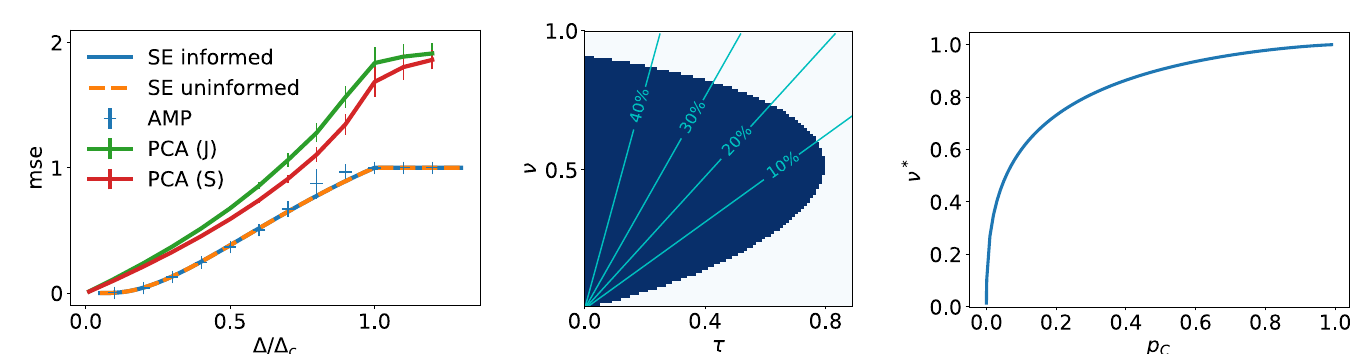
Fig 1. ( Left ) Reconstruction and performance of the message-passing algorithm for binary patterns. We plot the mse (7) obtained by the AMP algorithm (32) as a function of the effective noise Δ (9) (blue crosses). We plot the performance of the algorithm starting from random (15) and informed (16) initialisations. Solid lines depict the prediction obtained from iterating the state evolution Eq (14). Having Δ / Δ > 1 corresponds to the white region in the phase diagram on the right. We also c plot the mse of the reconstruction obtained by applying PCA to the weight matrix J and to the Fisher matrix S (31) (green and red, resp.) Parameters: τ = 0. N = 5000 for AMP, N = 20000 for PCA. (Center) Phase diagram for the rectified Hopfield channel with P = 1. We plot whether reconstruction of the patterns better than a random guess is easy (blue) or impossible (white) using the message-passing algorithm as a function of the constant threshold τ and the variance ν of the Gaussian noise appearing in the connectivity structure (3). The solid lines are the contours of the connection probability p C ( ν , τ ) (4). (Right) Critical noise ν � as a function of . We plot ν � , the largest variance of the additive Gaussian noise z at which reconstruction remains possible, against the probability p (4) connection probability p C ij C that any two neurons are connected.